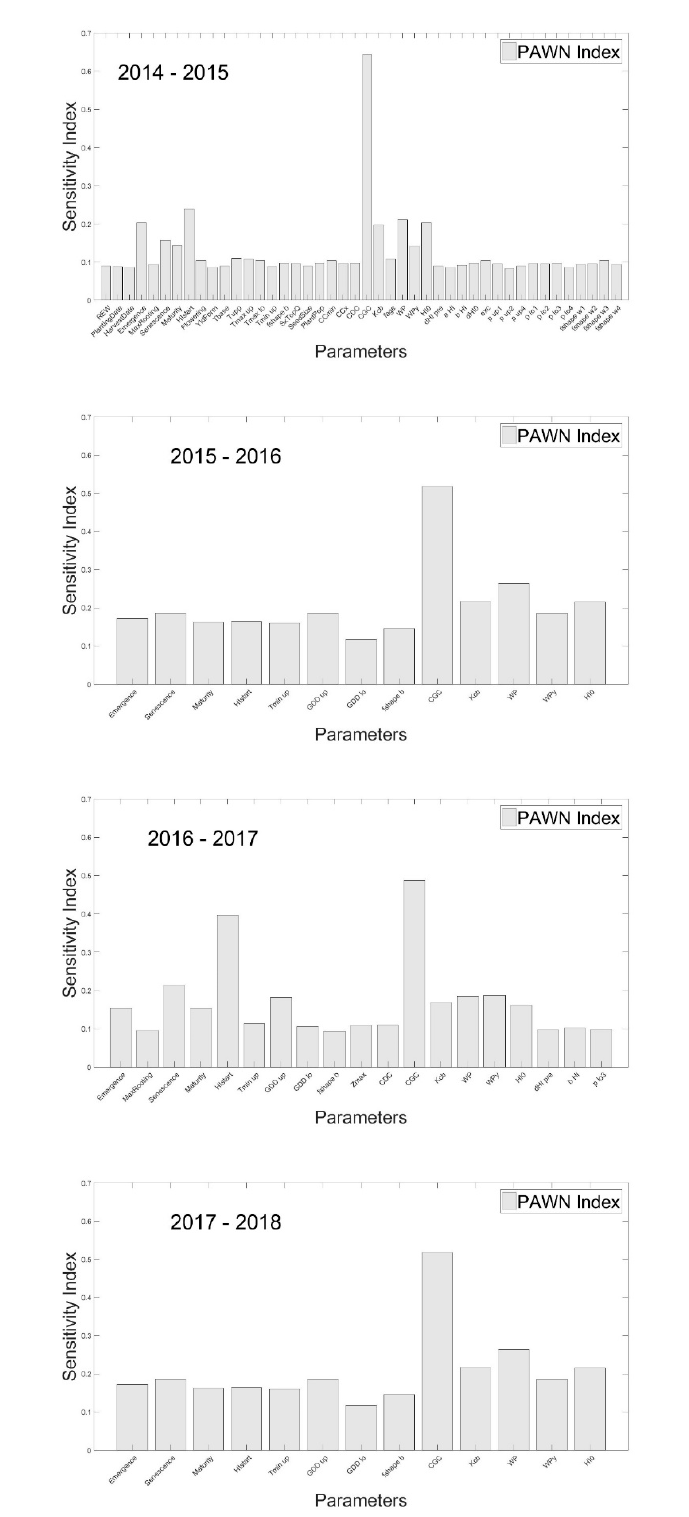
Figure 7. PAWN sensitivity index T i for different years for the Maccarese location. Only the parameters with a total sensitivity index higher than the sensitivity index of the dummy parameter are shown. The details on the parameters can be found in Table 1.